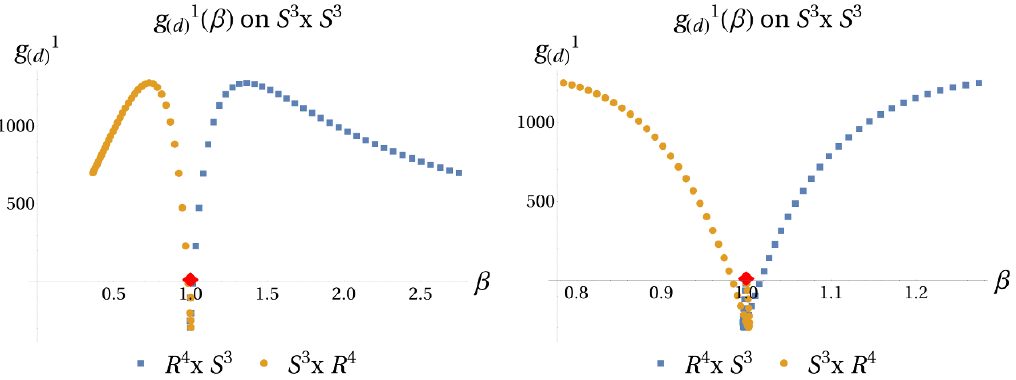
Figure 10 . g 1 as a function of the ratio of radii (cid:12) for both topologies with conformal boundary ( d ) S 3 (cid:2) S 3 . This is proportional to the expectation value of the energy-momentum tensor. The red diamond is the analytical calculation for the singular ratio (cid:12) s